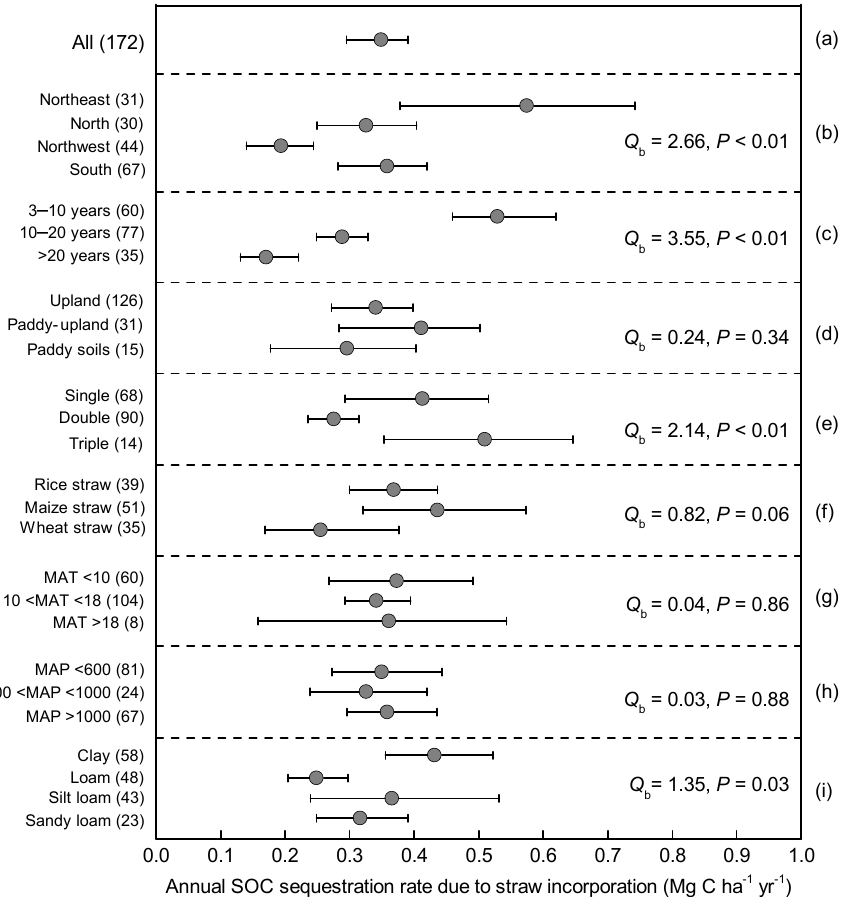
Figure 5. Responses of soil organic carbon (SOC) to SI compared with SR (a) categorized into (b) region, (c) experiment duration, (d) land use, (e) crop frequency (seasonyr − 1 ), (f) straw type, (g) mean annual temperature (MAT), (h) mean annual precipitation (MAP) and (i) soil texture. The SOC responses are expressed as the average annual SOC sequestration rate (Mg Cha − 1 yr − 1 ) with 95% CIs represented by the error bars. Numbers of paired observations are in parentheses. Between-group heterogeneity ( Q b ) and the probability ( P ) were used to describe statistical differences of SOC responses between different levels of the categorized